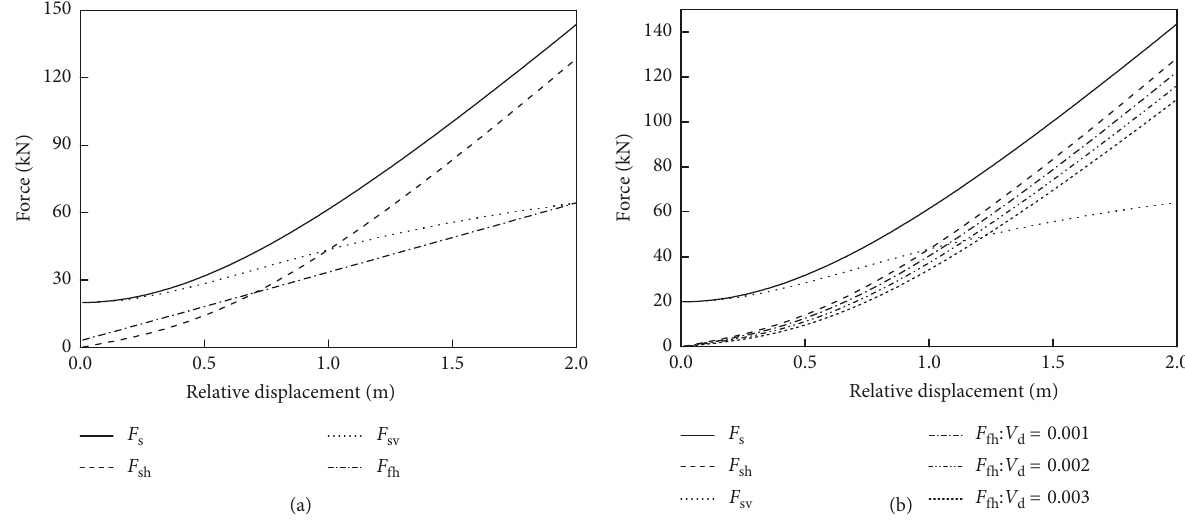
Figure 13: Force-displacement relationship when K